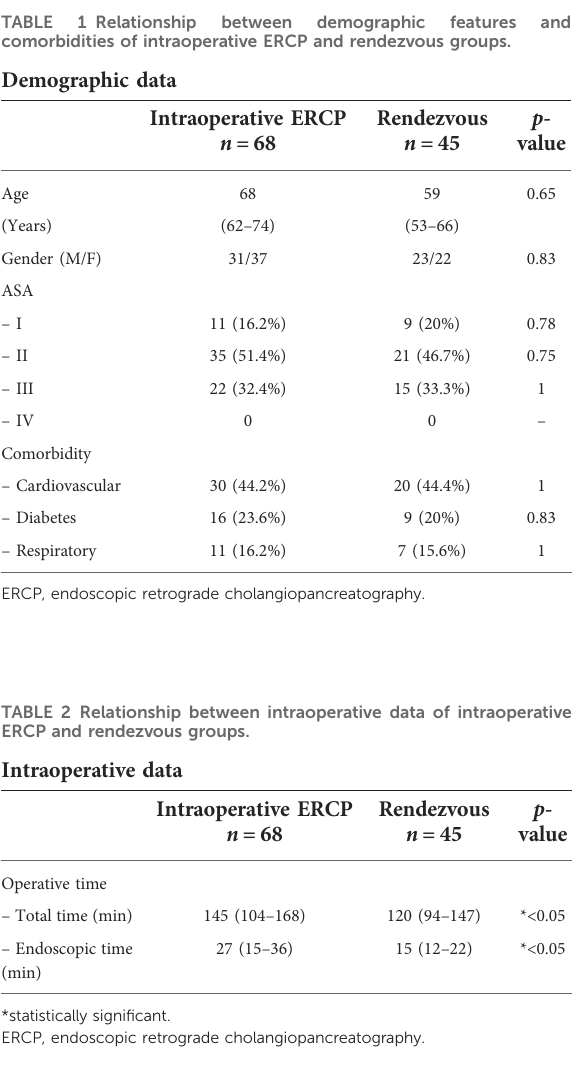
TABLE 1 Relationship between demographic features and comorbidities of intraoperative ERCP and rendezvous groups.